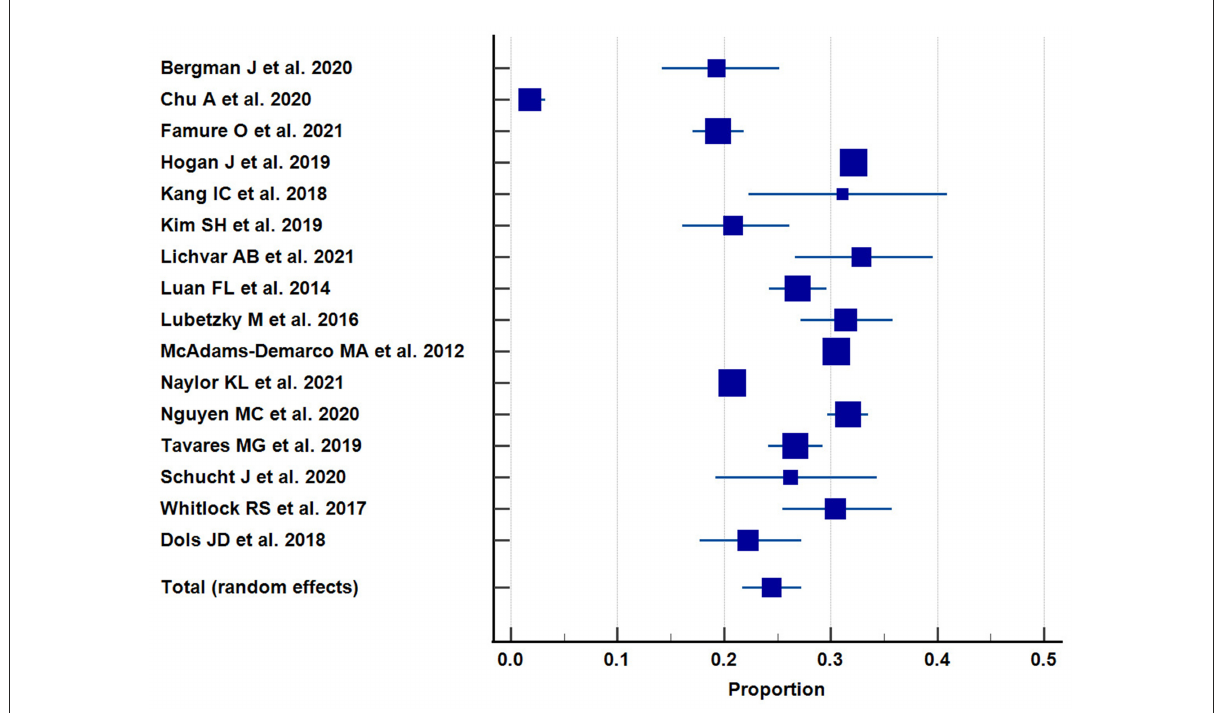
FIGURE2 The pooled incidence of 30-day readmission after kidney